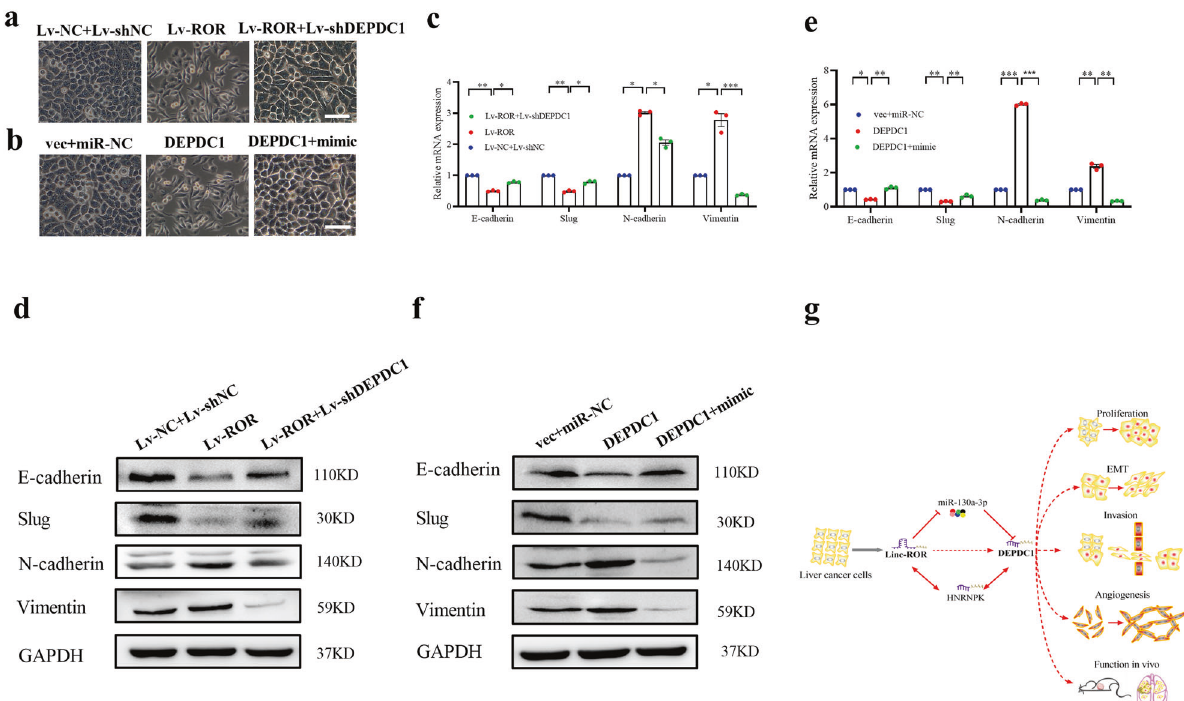
Fig. 8 Linc-ROR and DEPDC1 induces EMT and cell invasion in vitro. a Phase-contrast micrographs of Linc-ROR overexpressing cells, Lv-NC + Lv-shNC cells and Lv-ROR + Lv-shDEPD. C1 cells. Scale bars = 50 μ m. b Phase-contrast micrographs of DEPDC1-overexpressing cells, vec + miR-NC cells and DEPDC1 + mimic cells. Scale bars = 50 μ m. c , d The transcriptional and translational levels of EMT-related markers. The qRT- PCR and western blot assays were performed at 48 h after the Linc-ROR overexpressing cells treated with shDEPDC1. e , f The transcriptional and translational levels of EMT-related markers. The qRT-PCR and western blot assays were performed at 48 h after the DEPDC1- overexpressing cells treated with miR-130a-3p mimic. g The schematic model of Linc-ROR functions during the hepatocarcinogenesis and angiogenesis. Linc-ROR promotes HCC cell progression and angiogenesis by competitively binding the miR-miR-130a-3p, upregulating DEPDC1, and then inducing EMT. On the other hand, Linc-ROR interacts with HNRNPK to regulate DEPDC1 mRNA stability, while speci fi cally regulates DEPDC1 by facilitating interaction of HNRNPK with DEPDC1 mRNA. Data are shown as mean ± SD, n = 3. The data statistical signi fi cance is assessed by Student ’ s t test. * P < 0.05, ** P < 0.01, *** P < 0.001.